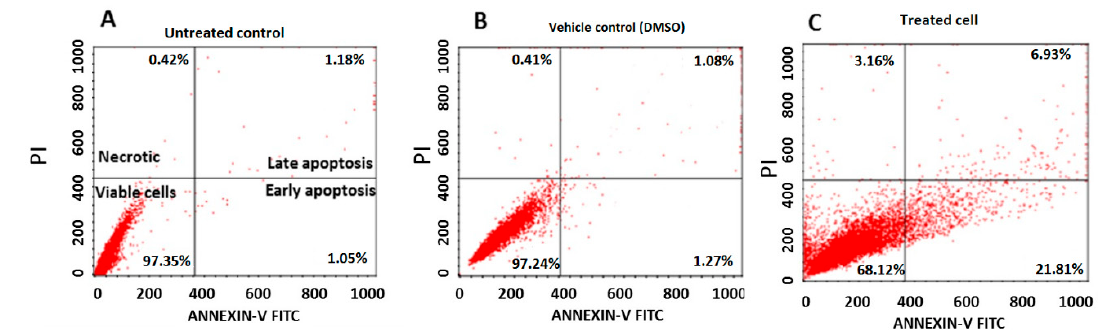
Figure 4. Flow cytometric analysis (Annexin V-FTIC / PI assay) of MCF-7 cells exposed for 24 h to 4b ( C ) (approximately 2x IC 50 value), respectively. A = untreated control, and B vehicle control (DMSO). The represented dot plots showing percentage of viable, early apoptotic, late apoptotic, and necrotic cells. These results show the ability of 4b to induce apoptosis in cancer cells and may deliver an excellent sca ff old for the development of anti-cancer drug